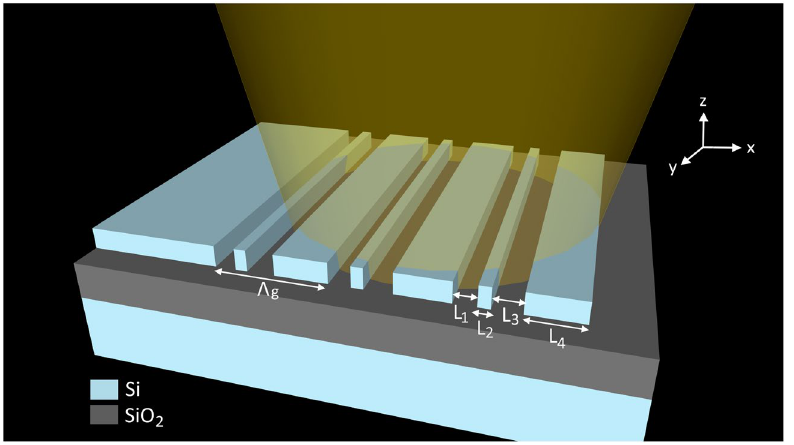
Figure 1. Schematic of the single-etch, un-chirped antenna with grating period Λ g and structural parameters [L 1 , L 2 , L 3 , L 4 ]. A transverse electric (TE) waveguide mode is incident from the